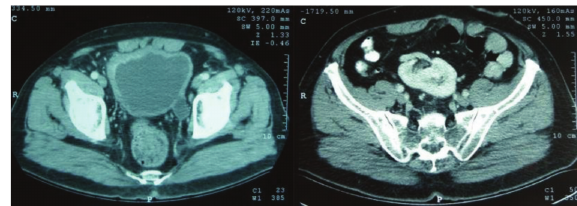
Figure 2: Postoperative CT of case 1.